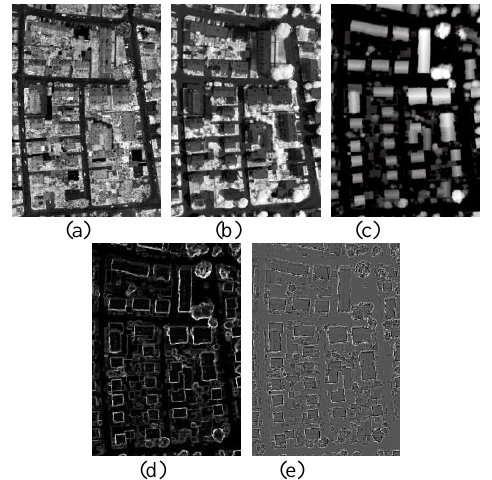
Figure 7: The produced features of Area2, (a) Intensity image of LiDAR, (b) NDVI , (c) nDSM , (d) Slope, (e)